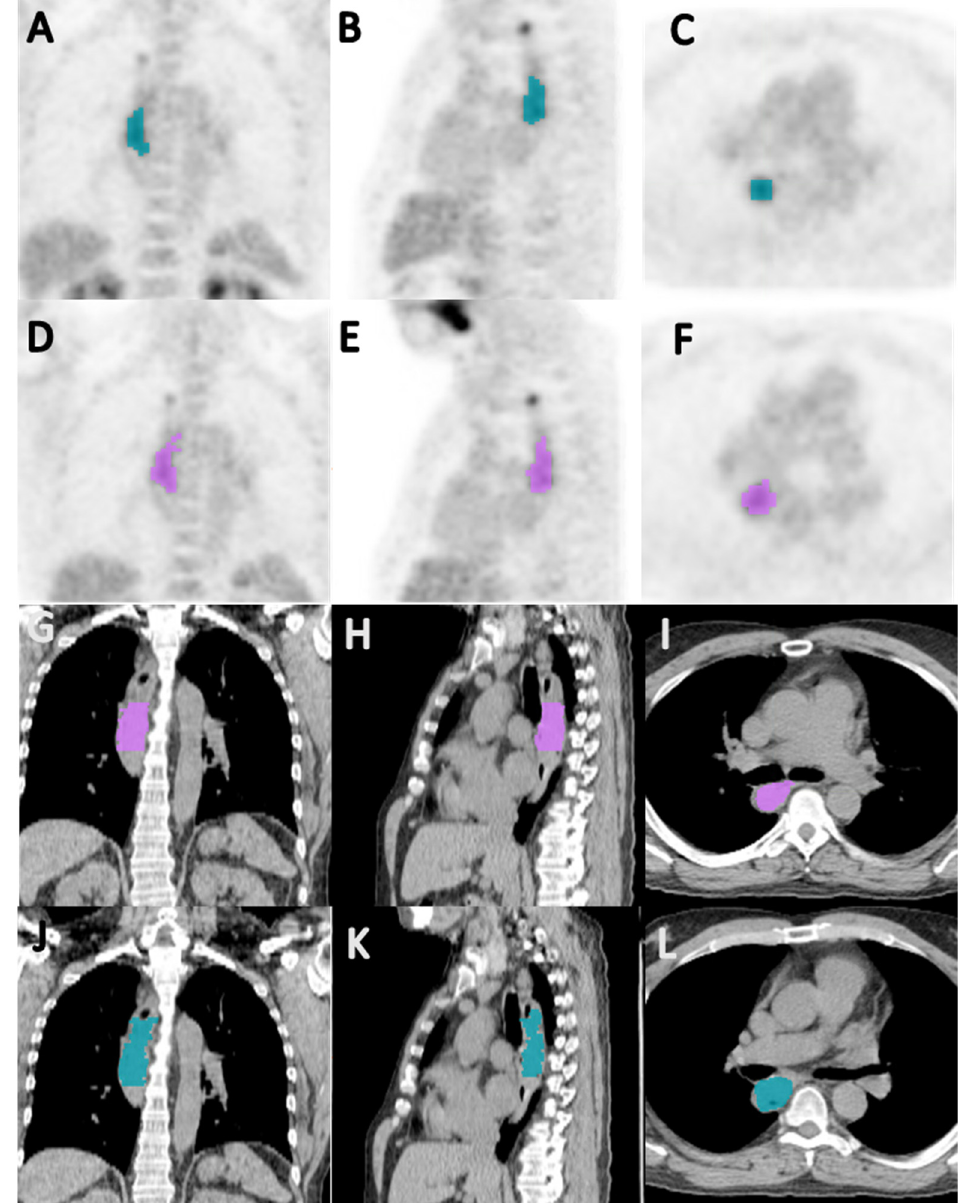
Figure 2. Coronal ( A , D ), sagittal ( B , E ), and axial ( C , F ) PET images, and coronal ( G , J ), sagittal ( H , K ), and axial ( I , F ) CT images showing segmentation of primary tumor by reader 1 ( A – C , G – I ) and reader 2 ( D – F , J – L ), in a 64-year-old male patient with esophageal squamous cell carcinoma; the Jaccard index and a dice similarity coefficient for inter-reader agreement on the segmented volumes were 0.657 and 0.793, respectively.